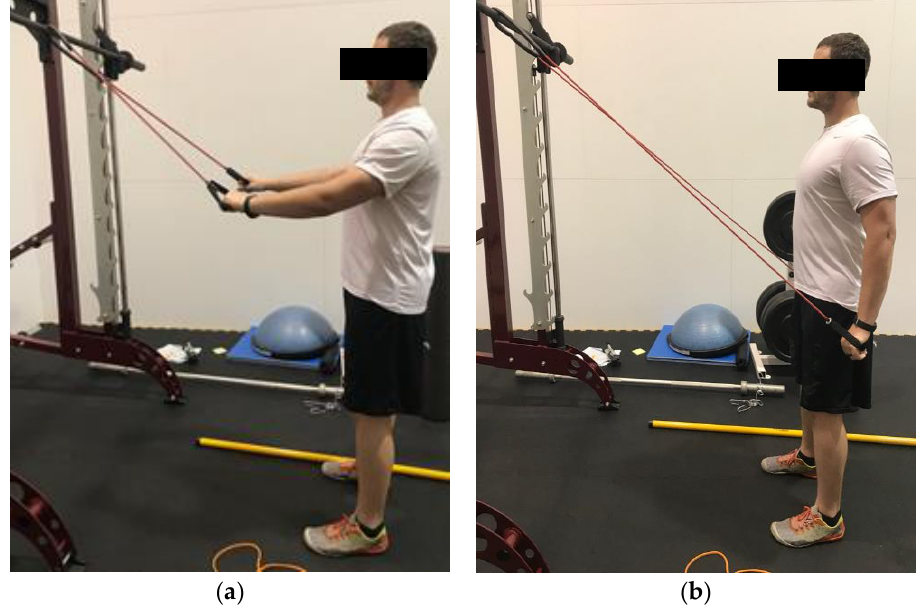
Figure 4. Demonstration of banded straight arm extension in the ( a ) start position; ( b ) end position. Arms start either elevated or parallel with the ground. The elbows stay slightly flexed, and the hands are brought down to the thigh while keeping the arms straight.